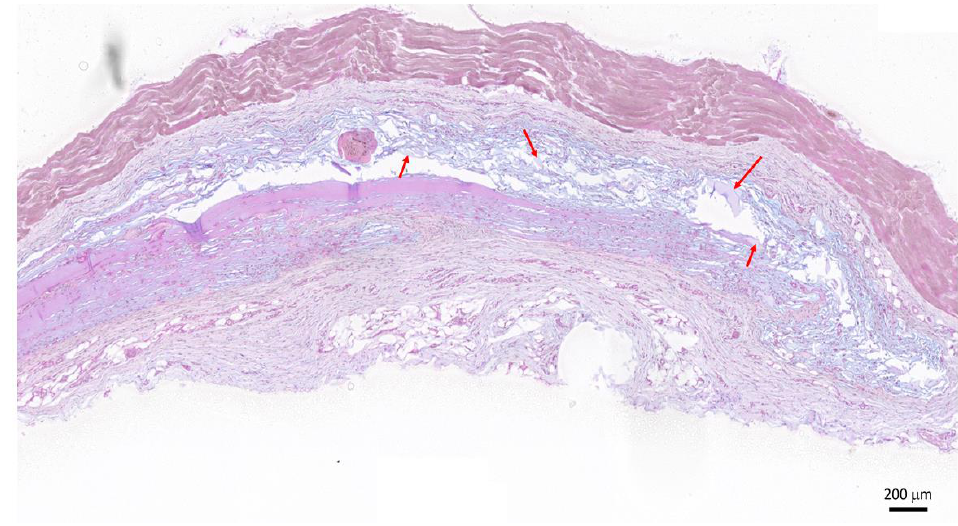
Figure 6. Histological section of the HA-Dop implant area 28 days after implantation, hematoxylin/eosin and alcian blue staining. Red arrows indicate the blue-stained HA residues. Scale bar: 200 μm.